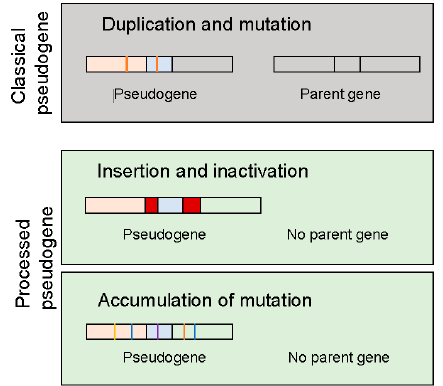
Figure 1. Types of pseudogenes. See detailed explanation in the text.